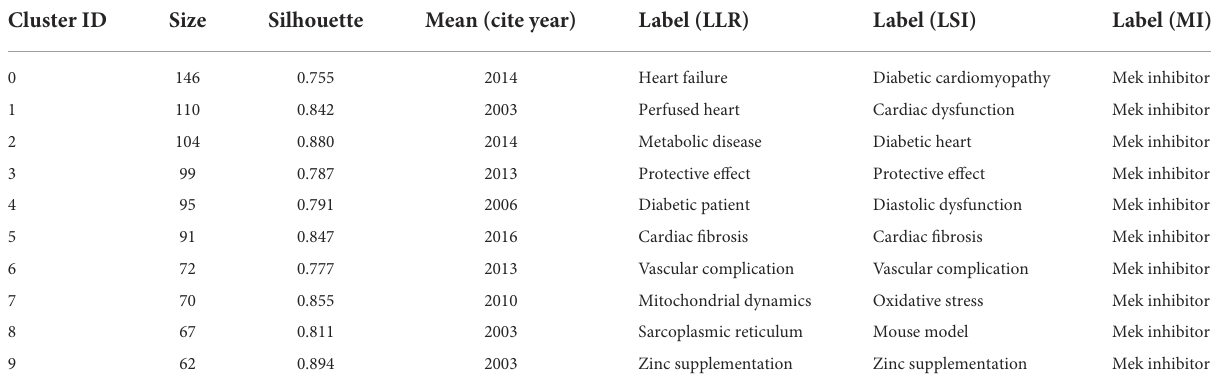
TABLE 3 The largest 10 clusters of diabetic cardiomyopathy research document co-citation, identified by subject headings. Cluster ID